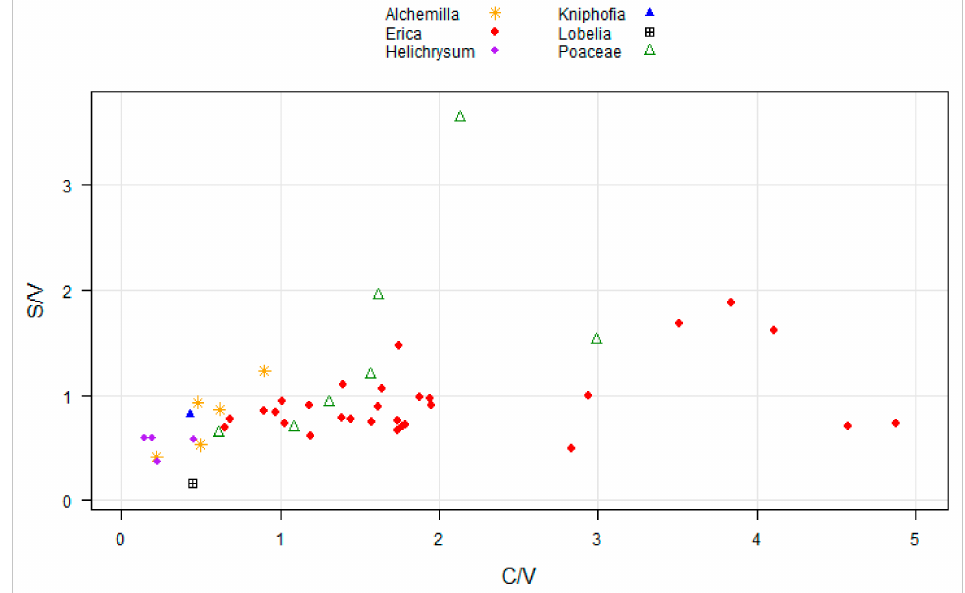
Figure 5. Two-dimensional plot illustrating the ratios of syringyl vs. vanillyl (S / V) and coumaryl vs. vanillyl (C / V) phenols of the dominant plant species under